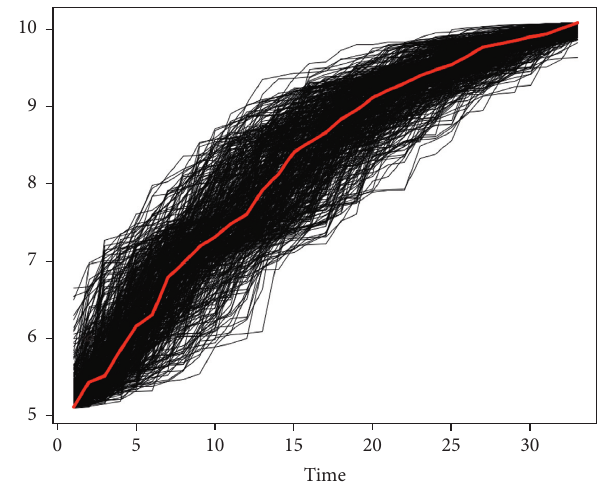
Figure 3: Lombardia: B � 500 bootstrap replications performed via the MEB algorithm on the adjusted, log-transformed, data (in red, the original time series is depicted).